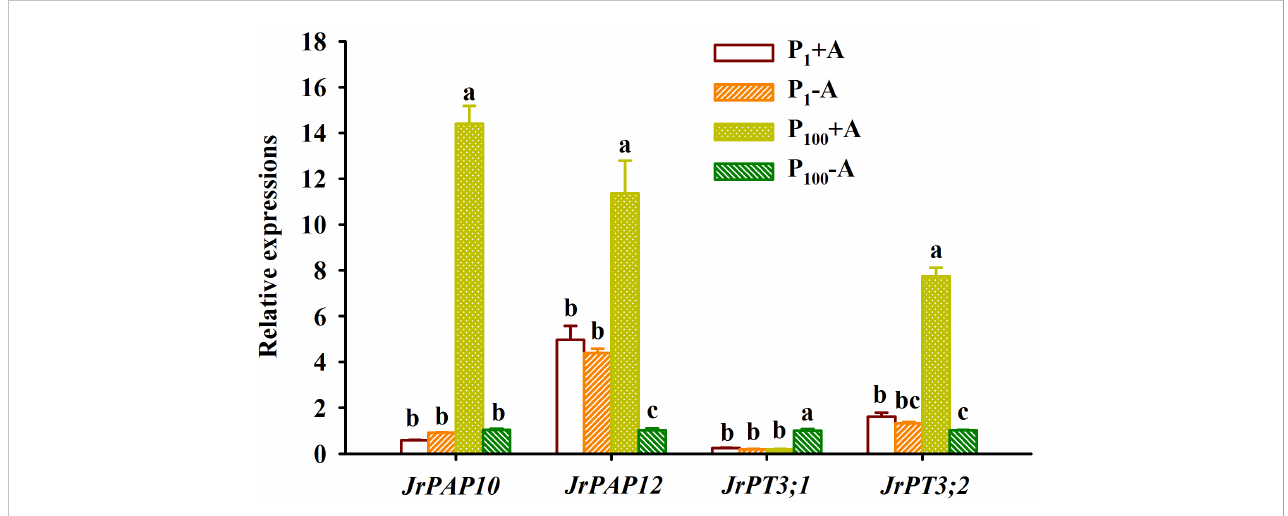
FIGURE 7 Changes in expressions of purple acid phosphatase ( PAP ) and phosphate transporter ( PT ) in leaves of walnut seedlings inoculated with Diversispora spurca grown in 1 and 100 m mol/L phosphorus levels. Data (means ± SD, n = 3) followed by different letters above the bars indicate signi fi cant ( P < 0.05) differences. The abbreviations were shown in Figure